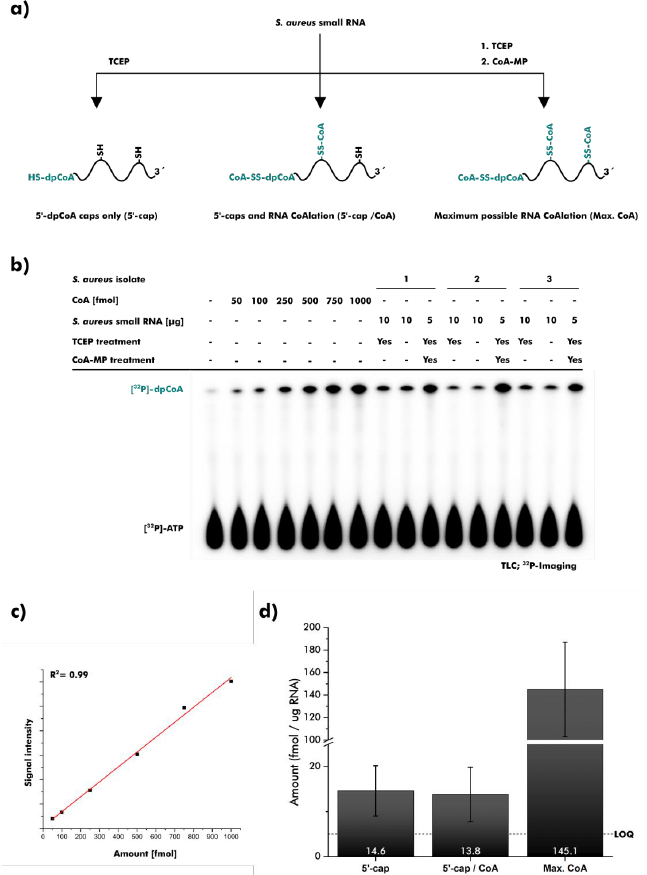
Figure 3. Quantification of dpCoA-RNAs and RNA CoAlation in S. aureus , grown in the absence of oxidative stress. ( a ) Schematic overview. Three different procedures were applied to small RNA isolates prior to quantification: treatment with tris(2-carboxyethyl)phosphine (TCEP), no pre-treatment, or treatment with TCEP and 2-mercaptopyridine-activated CoA (CoA-MP). ( b ) dpCoA caps and CoAlation events were analyzed after separation using thin-layer chromatography (TLC). Signals were visualized using 32 P-imaging. [ 32 P]-dpCoA sig- nals were quantified. ( c ) CoA was used to create a calibration line for 50 – 1000 fmol CoA and dpCoA-RNA. ( d ) The bar chart illustrates the amount of dpCoA-RNAs and CoA in one mi- crogram small RNA of S. aureus . 5′ -dpCoA caps ( 5′ -cap) were quantified. A combination of 5′ -dpCoA caps and in vivo CoAlation events ( 5′ -cap/CoA) was quantified. Potential CoA- lation sites (Max. CoA) in S. aureus small RNA were quantified. Error bars represent the standard deviation (n = 3). The limit of quantification (LOQ) is 50 fmol.